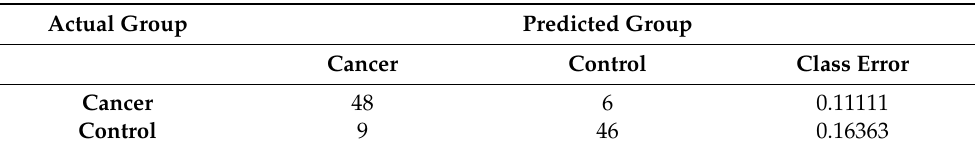
Figure 5. Hierarchical clustering using the top 10 discriminatory metabolites in the training set ( n = 109, cancers = 54, controls = 55) based on mean decreasing accuracy. The difference in intensities of the top 10 metabolites by cancer-control status is shown. Each coloured cell in the map represents scaled/relative concentration of indicated metabolite. Metabolites are clustered along the vertical axis while subjects are clustered along the horizontal axis. Hierarchical clustering was based on the Euclidean distance measure and the Ward algorithm. Table 2. Random forest diagnostic accuracy based on the training set made from 80% cases and controls ( n = 109, cancers = 54, controls = 55).